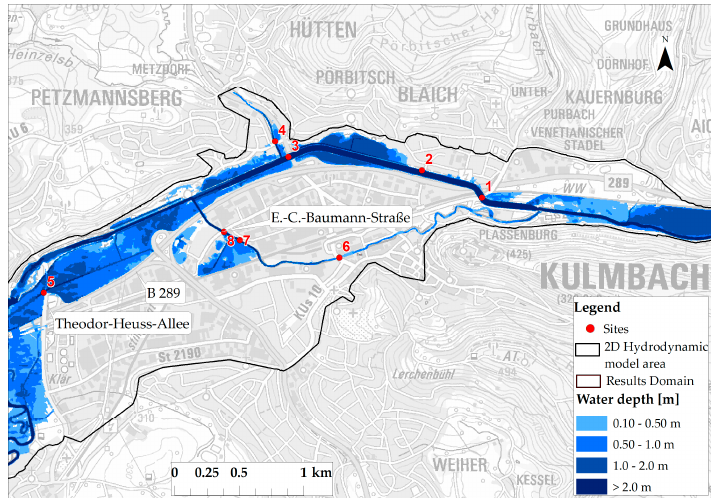
Figure 6. Inundation map of the city of Kulmbach on 14 January 2011 at 14:00.